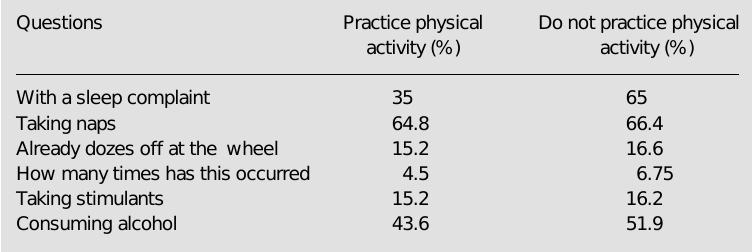
Table 7 - Data concerning the drivers in relation to the presence or absence of physical activity (N =